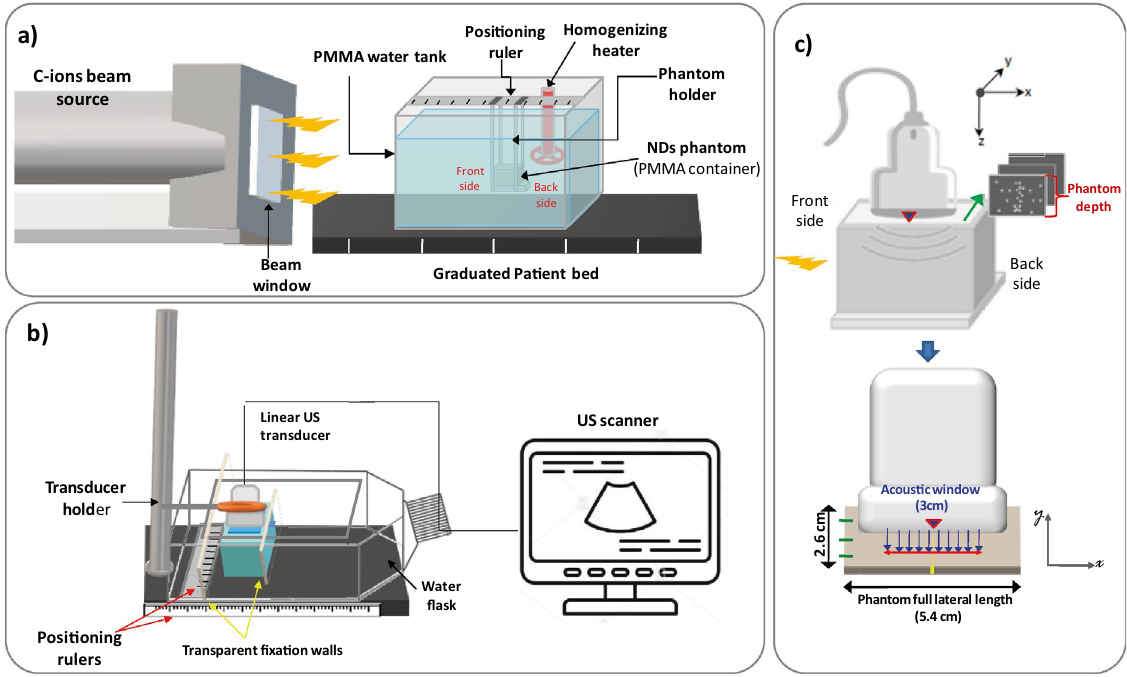
Figure 1. C-ions exposure experiment of PVA/PFB NDs entrapped in PAM tissue-mimicking phantoms and filled in PMMA containers: ( a ) Representative scheme of the C-ions irradiation setup; ( b ) Offline US imaging setup of PVA/PFB NDs phantoms pre- and post-irradiation at 7.5 MHz frequency and mechanical index MI = 0.1 (the probe is positioned on top of the phantom); ( c ) Depiction of the imaging scan of the phantoms along the Y axis of the PMMA container (green arrow), and of the acoustic window considered for each image (the red line indicates extent of the lateral length of the acoustic window, i.e. 3 cm). The center of the probe was aligned with the middle of the internal length of the phantom container (red triangle and yellow mark), i.e. parallel to the beam direction. The green marks indicate the probe positioning for a phantom scan through the y axis (acquisition of 3 ROIs).